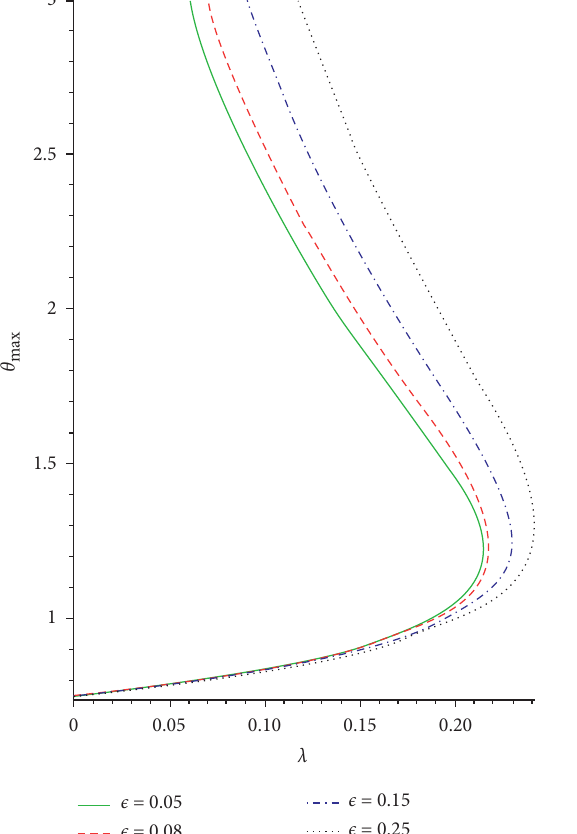
0.5m = m = Figure 9: Criticality bifurcation for various m